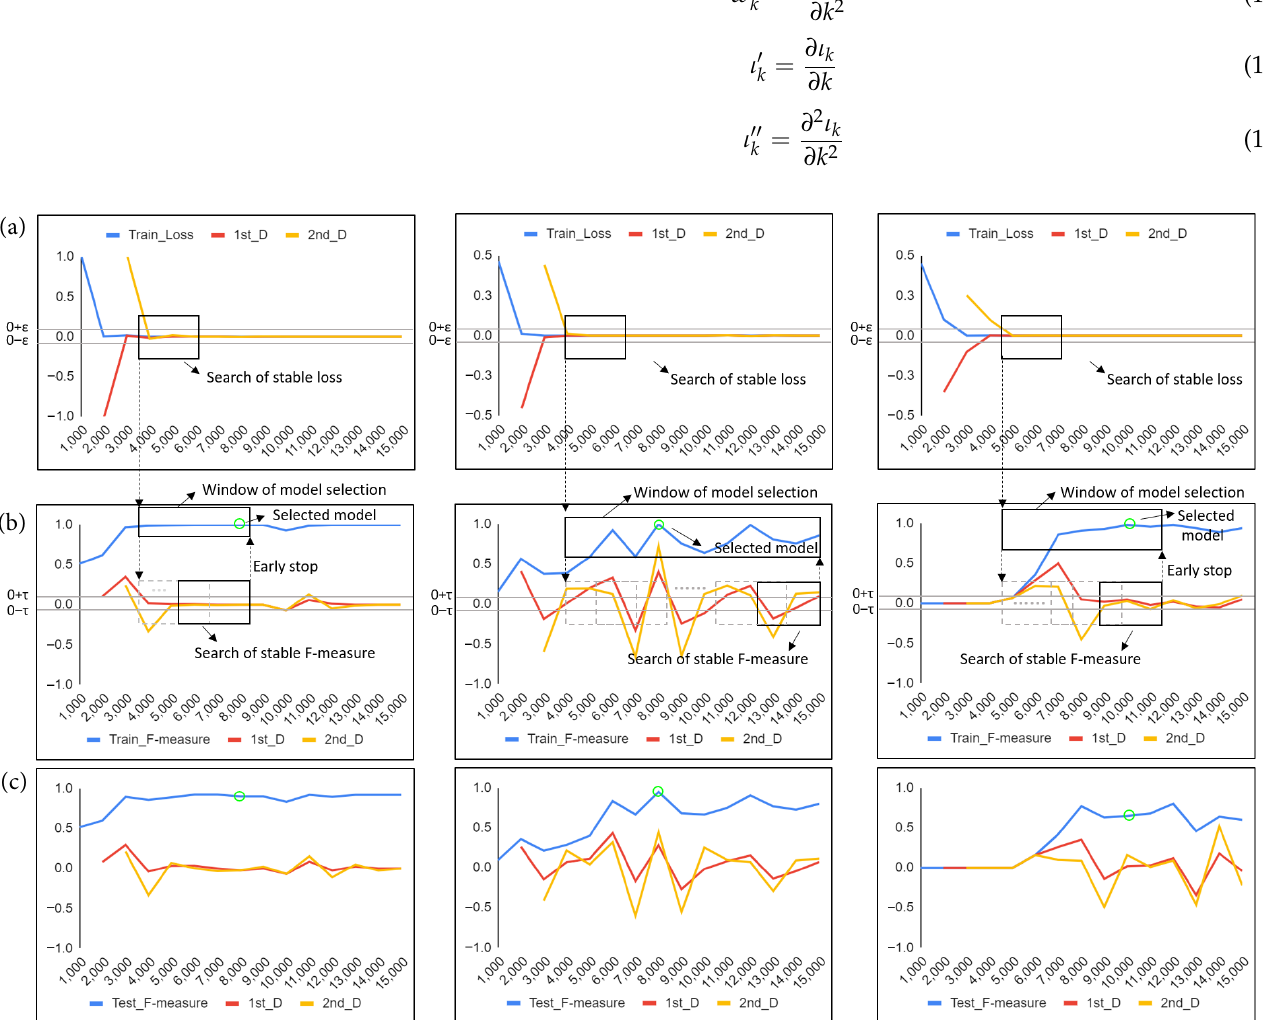
Figure 4. Illustration of the proposed model selection method with three examples: ( a ) loss values of models through iterations during training; ( b ) F-measure scores of individual models with different iterations on the training set; ( c ) F-measure scores of individual models with different iterations on the testing set. The blue lines indicate the measurement values, and the red and yellow lines represent the associated first and second derivatives, respectively. During training, the proposed model selection method computes the loss values and F-measure scores of trained models on the training set and further calculates associated first and second derivatives. If a stable loss is found in ( a ) where the first and second derivatives of the training loss converge for a continuous period, the starting point of the stable loss window is used as the starting point in model selection searching.